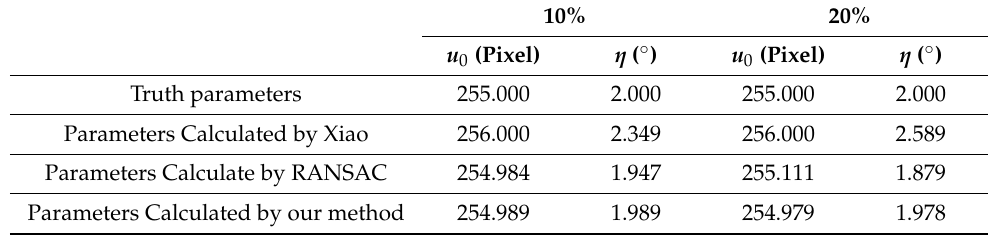
Table 3. Comparison of simulation experimental data parameters with noise.